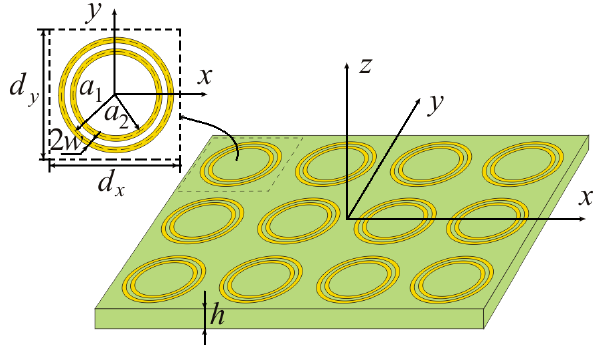
Figure 1. Array of two concentric metal rings on a substrate made of active material.